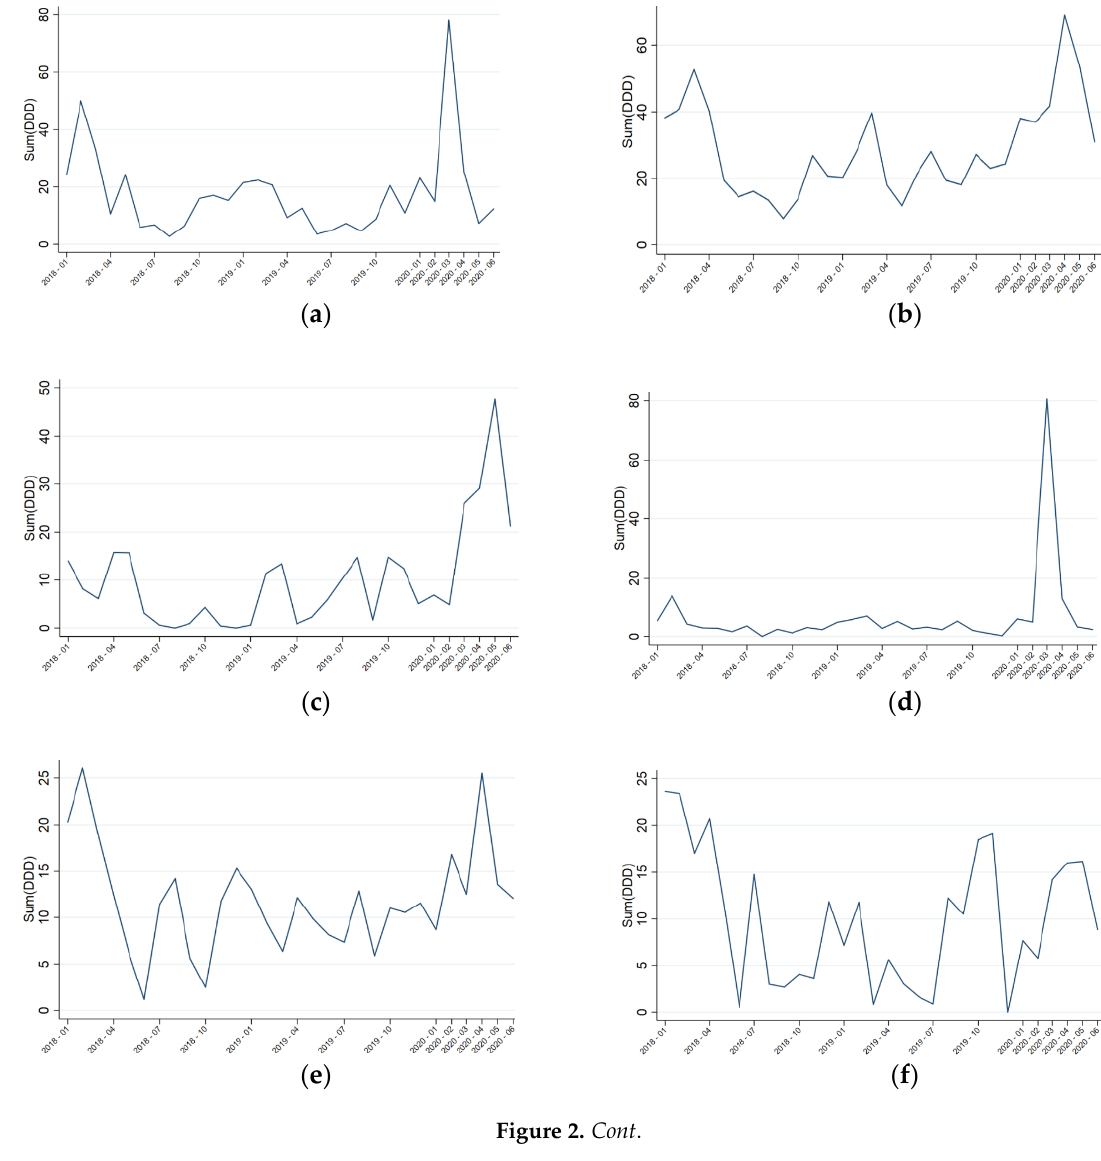
Figure 1. Evolution of drug consumption in hospital expressed in defined daily doses (DDD)/100 bed-days. ( a ) Ceftaroline: β-change 11.771, p = 0.014; ( b ) azithromycin: β-change 63.129, p = 0.085; ( c ) ceftriaxone: β-change 18.390, p = 0.692; ( d ) carbapenems: β-change –12.714, p = 0.592; ( e ) tria- zoles: β-change 17.601, p = 0.333; ( f ) linezolid β-change 13.725, p = 0.211; ( g ) liposomal amphoteri-